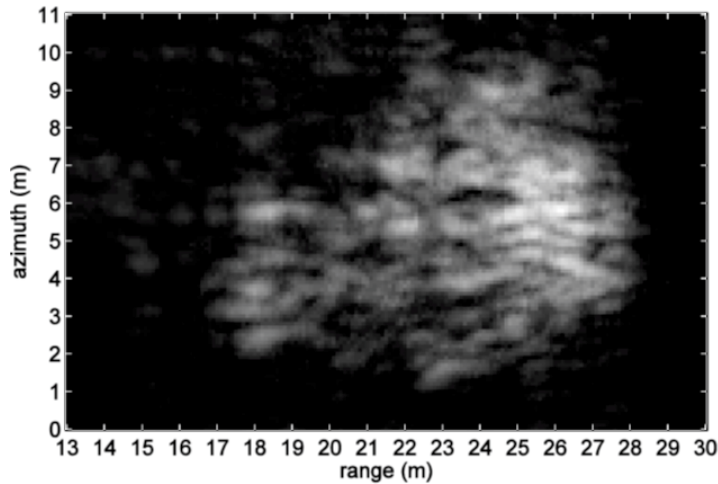
Figure 11. Projected tree backscatter image from Figure 11 as would be observed by a high resolution C ‐ band SAR at an incidence angle of 50°. Shadowing is not included. This synthesized SAR image can be compared to the actual SAR image of a different tree in Figure 3. The arbitrary linear grayscale extends from black for low backscatter to white for high backscatter.